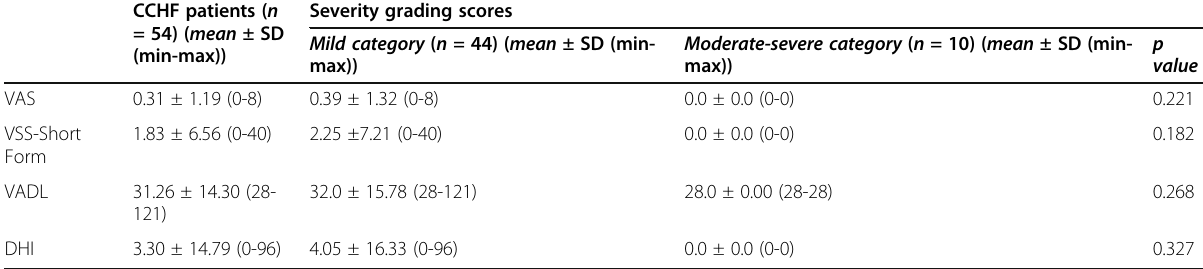
Table 3 VAS, VSS-Short Form, VADL, and DHI mean scores of the